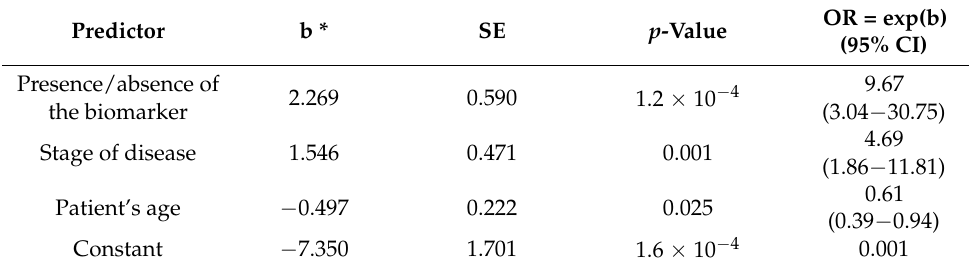
Table 4. Results of multivariate analysis of clinical outcome of the